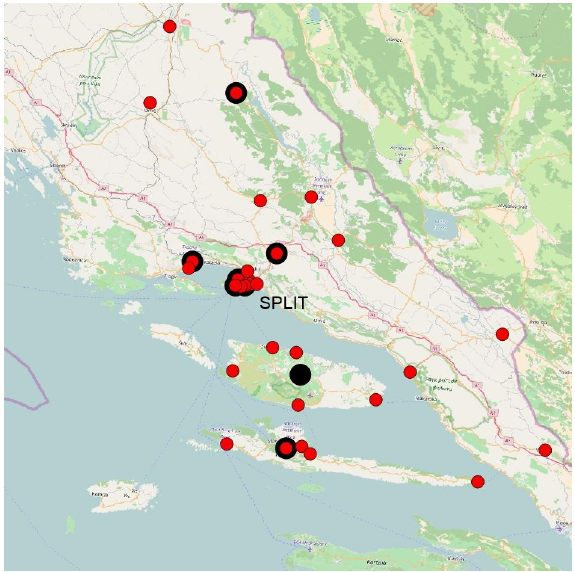
Figure 1: Map showing locations of ‘points of interest’ (the first analysis - black circles, the second analysis - red circles) (backdrop map © OpenStreetMap 2017) The first analysis clearly shows that the number of foreign tourists significantly grows starting from the beginning of April with peaks during international events such as regatta, but it does not correlate with the start of cruiser season. For the city of Split and for the time period from April to May, the number of foreign tourist is the following: 30% of tourists are from Bosnia & Herzegovina, 24% from Germany, 9% from the United Kingdom, 8% from the Netherlands, 7% from Italy and 22% from all other countries. Regarding traffic data, the first analysis shows that traffic volume follows the same trend as tourist data on county roads to the airport and ferry harbour. For the main roads in the city of Split, the first analysis clearly differentiates the roads with traffic volume corresponding to the number of tourist and the roads following the pattern of inhabitants (e.g. traffic volume higher during working days than